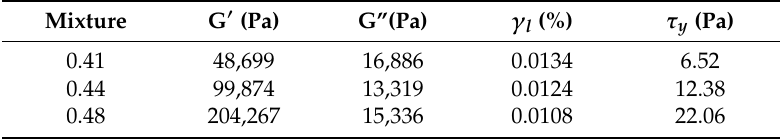
Table 2. Results from small amplitude oscillatory shear (SAOS)